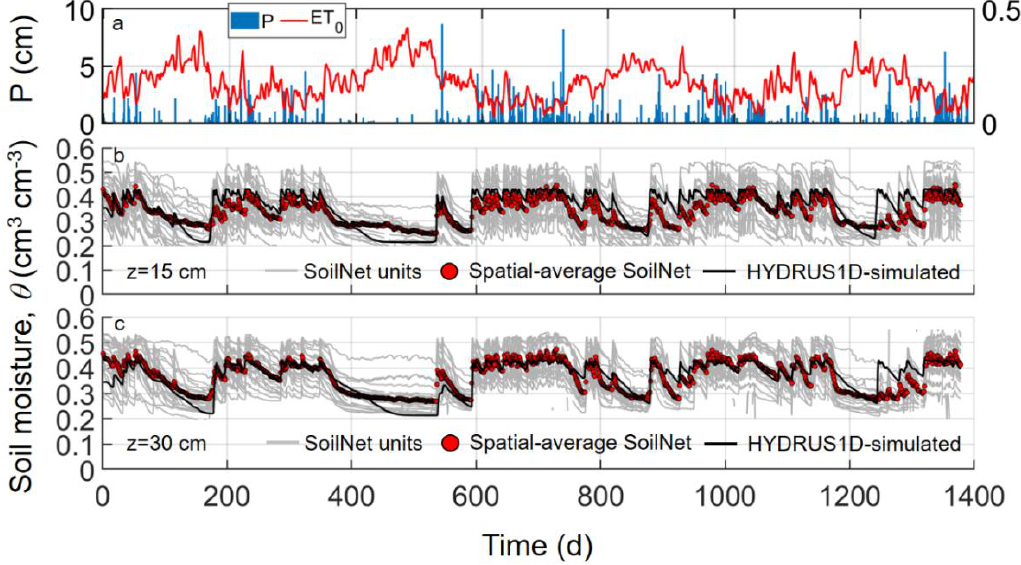
Figure 9. Time variations of observed versus simulated soil moisture content at MFC2 study site over the monitoring period from 24 March 2016 to 31 December 2019 (1378 days) and at the soil depths of 0.15 m (panel 9b) and 0.30 m (panel 9c). The top panel 9a reports the precipitation (P; blue bars and left axis) events occurring in this period and the time series of computed potential evapotranspiration (ET 0 ; red lines and right axis). The solid gray lines in panels 9b and 9c are soil moisture contents measured at the 20 sensor units of the SoilNet network, with the red circles being their daily average soil moisture contents.